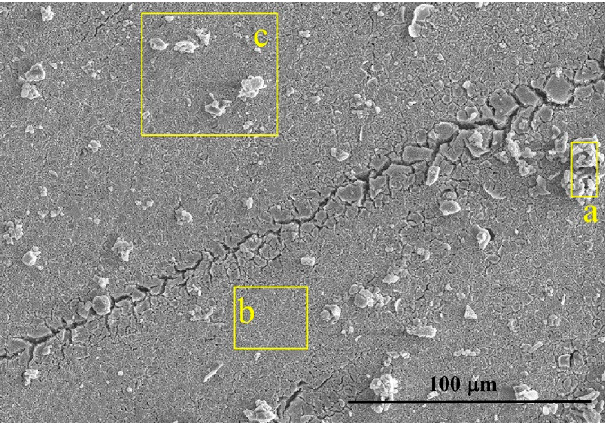
Figure 4. Morphology of the corroded surface when the potential reaches above 650mV. a—non-peeling tubers, b—deciduous position, c—area including non-peeling tubers and deciduous position.